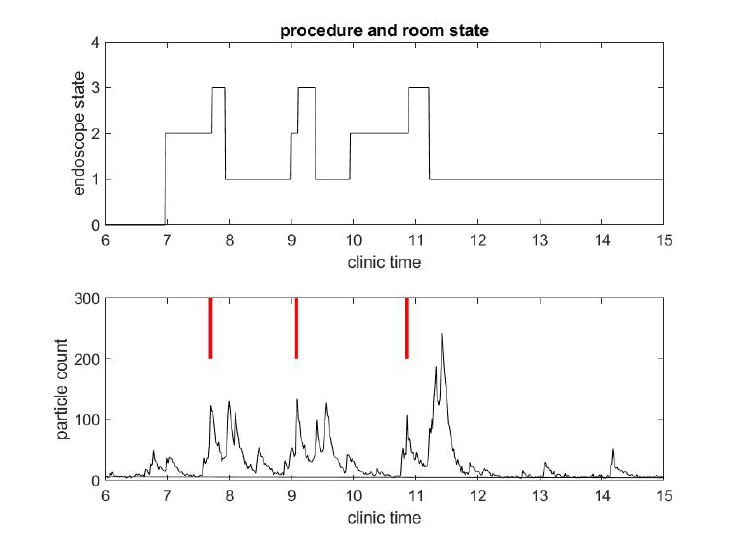
Figure 2. Example of small particle count during a clinical day in a procedural room. (Top ) the endoscope state, 0 for endoscope tower not in use, 1 for endoscope tower powered on, 2 for endoscope plugged in but not in use during procedure preparation, and 3 for in use during procedure; and ( Bottom ) the small particle count only, with red bars marking when the procedure in ( Top ) began.